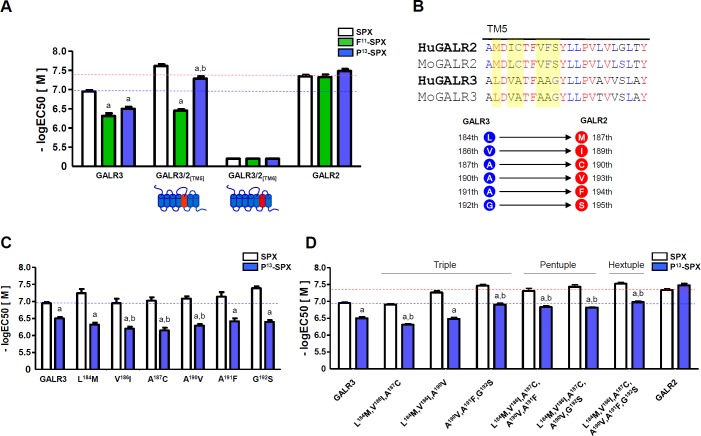
Identification of amino acid residues within the TM5 domain that interact with Pro13 of the ligand.(A) Responses to SPX, [P13]-SPX, and [F11]-SPX by chimeric receptors in which the TM5 or TM6 domains of GALR3 were replaced with the corresponding domains of GALR2. (B) Amino acid sequence comparison of the TM5 domains between human (Hu) and mouse (Mo) GALR2 and GALR3. (C) Responses to [P13]-SPX by GALR3 variants with the Leu184Met, Val186Ile, Ala187Cys, Ala190Val, Ala191Phe, and Gly192Ser single substitutions in the TM5 domain. (D) Reponses to [P13]-SPX by GALR3 variants with triple, pentuple, and hextuple substitutions in the TM5 domain. The horizontal red and blue dashed lines represent the responses of GALR2 and GALR3, respectively, to SPX. The EC50 values are presented as mean ± SE (a: P < 0.05 vs. SPX; b: P < 0.05 vs. WT GALR3).